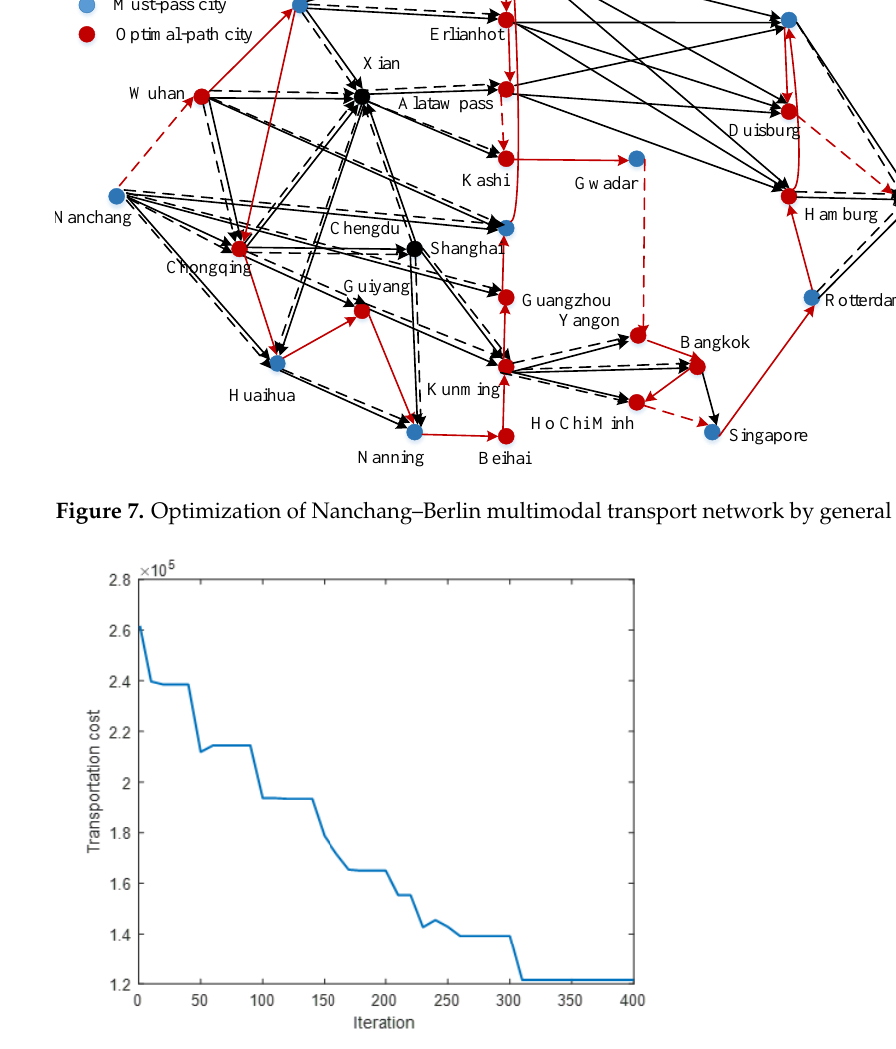
Figure 8. GA algorithm cost target iteration curve.